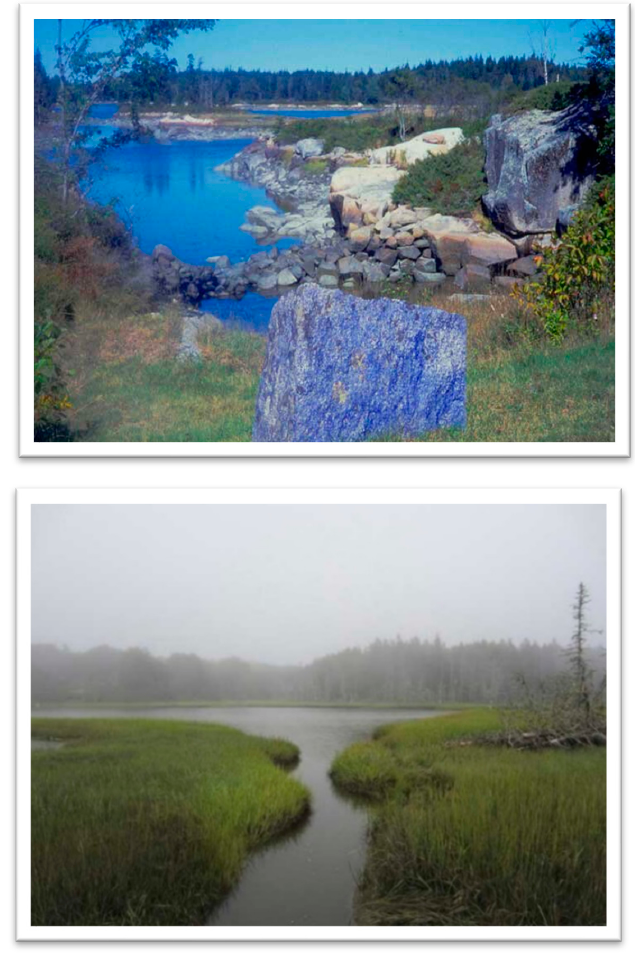
Figure 4. Aviva Rahmani, Blue Rocks , 2002–2012 (above: the rocks painted with blue colour, un- derneath: the state of the site of Pleasant River after Rahmani’s “blue colour-action” and after renaturation.). Source: https://www.avivarahmani.com/water-ecosystem-preservation-ecoart (ac- cessed on 30 August 2022). Courtey Aviva Rahmani.